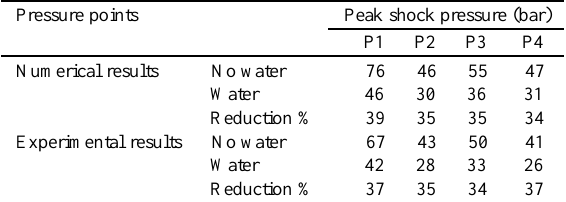
Fig. 4. Layout of the tunnel model and the locations of the pressure points. Table 4 Peak shock pressure for 750 g TNT detonation in the chamber system. The water/explosive ratio in the water case is